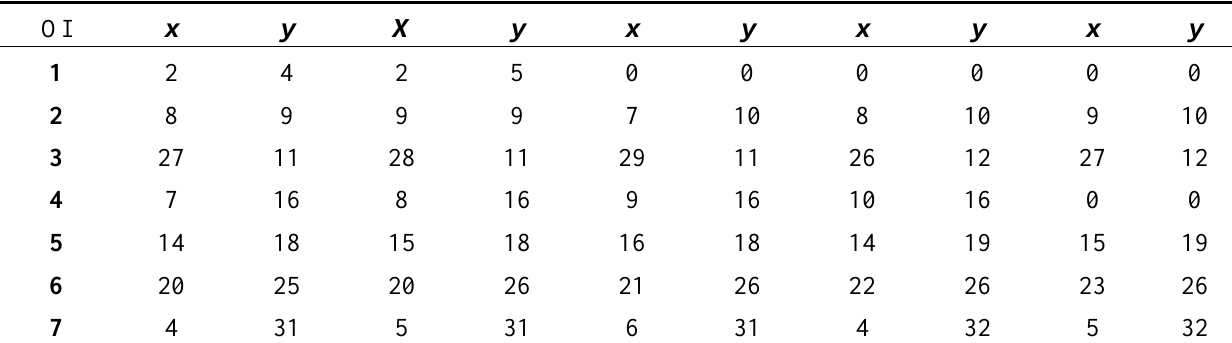
Table 1. Objects within Mat_Obj are ordered according to their occurrence through the rows of the FF